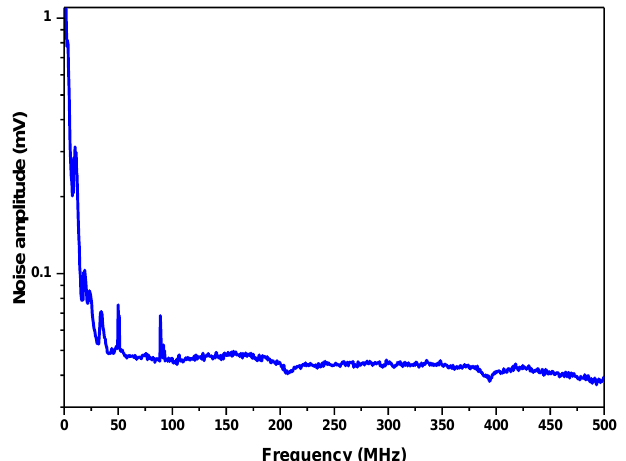
Figure 7. Noise amplitude spectrum from the RF output of the photomixer in the 1 kHz – 500 MHz range. The noise densities within the different pass-bands of the RF filters available in the present work were estimated by dividing the integral noise over each pass-band by both the bandwidth and the square root of the RBW (100 kHz) (Table 1). As shown in Table 1, the noise density of the RF filter with a pass-band of 27.5–270 MHz was the lowest, and the corresponding SNR was the highest because of its wider filter bandwidth. Table 1. Noise density with different RF filter pass-bands. Pass-Band (MHz) DC-270 DC-520